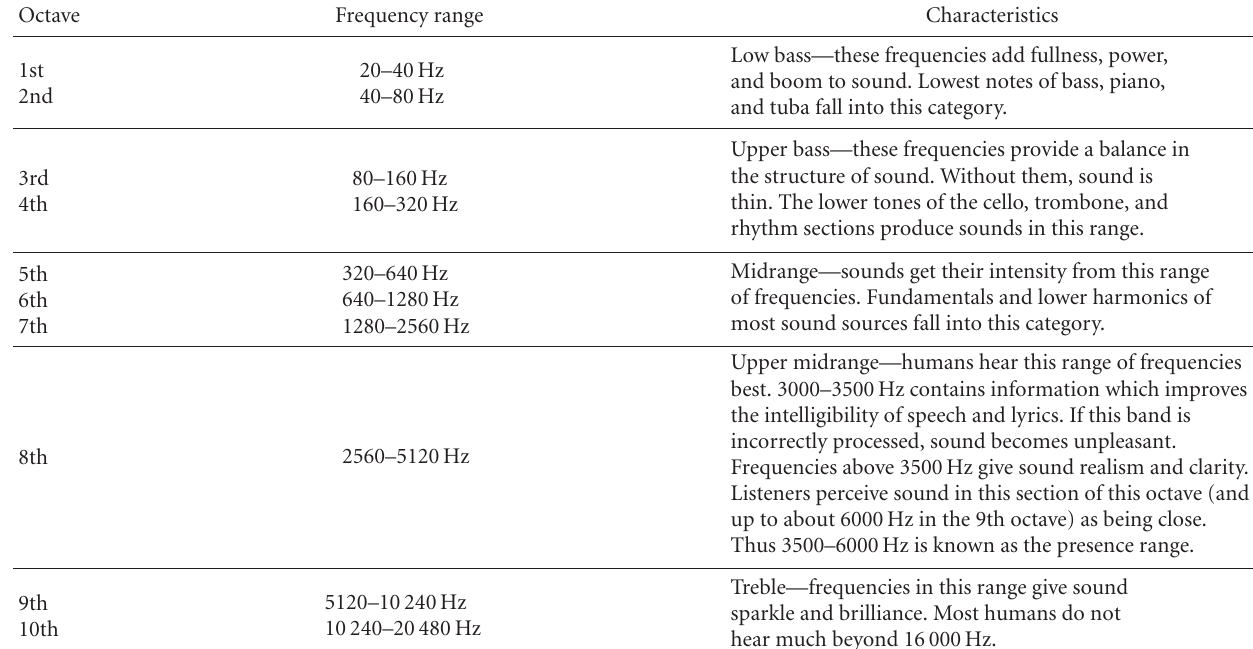
Table 1: Octave bands of human hearing and their